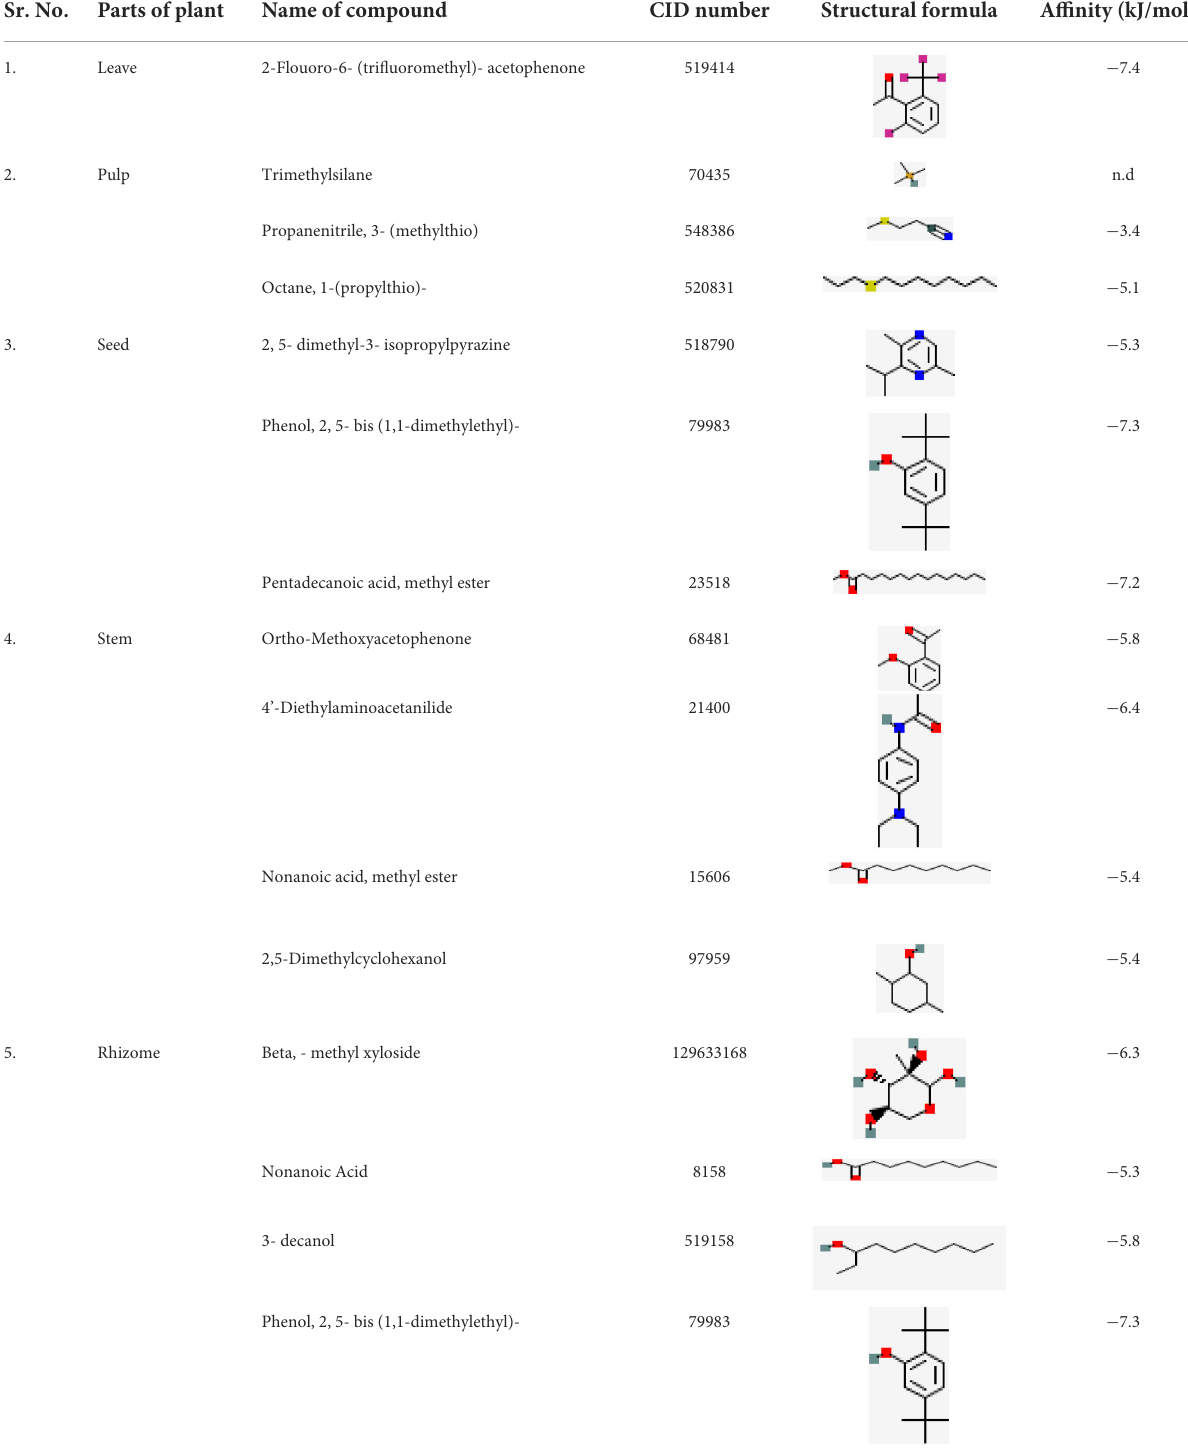
TABLE 2 Docking results of different parts of A. jacquemontii Blume along with their binding affinity. Sr. No. Name of compound CID number Structural formula Affinity